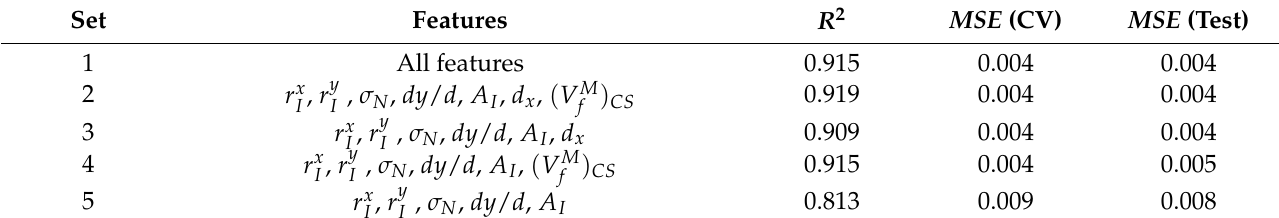
Figure 11. ( a ) Feature importance obtained from the random forest regression analysis of the effect of an inclusion on the bendability of the dual-phase steel. ( b ) A comparison of the bendability, normalized macroscopic flexural strain to failure, ε f / ε 0 , obtained from random forest regression analysis using feature set 2 in Table 3 and microstructure-based finite element calculations of 90 ◦ V-bending of the dual-phase steel. Table 3. Feature reduction using random forest regression analysis of the effect of an inclusion on the bendability of the dual-phase steel. The description of all the features are given in Table 2. The value of R 2 is the coefficient of determination of the fit, MSE (CV) is the mean squared error of the cross-validation predictions, and MSE (Test) is the mean squared error of the test